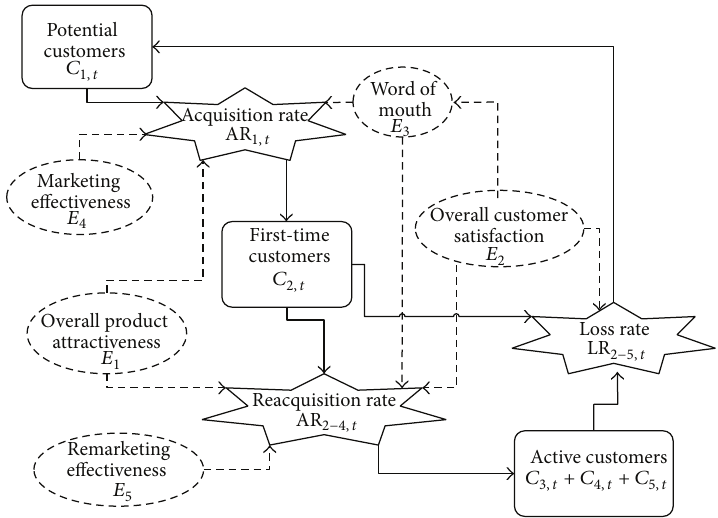
Figure 7: The relationship between influencing factors and AR or